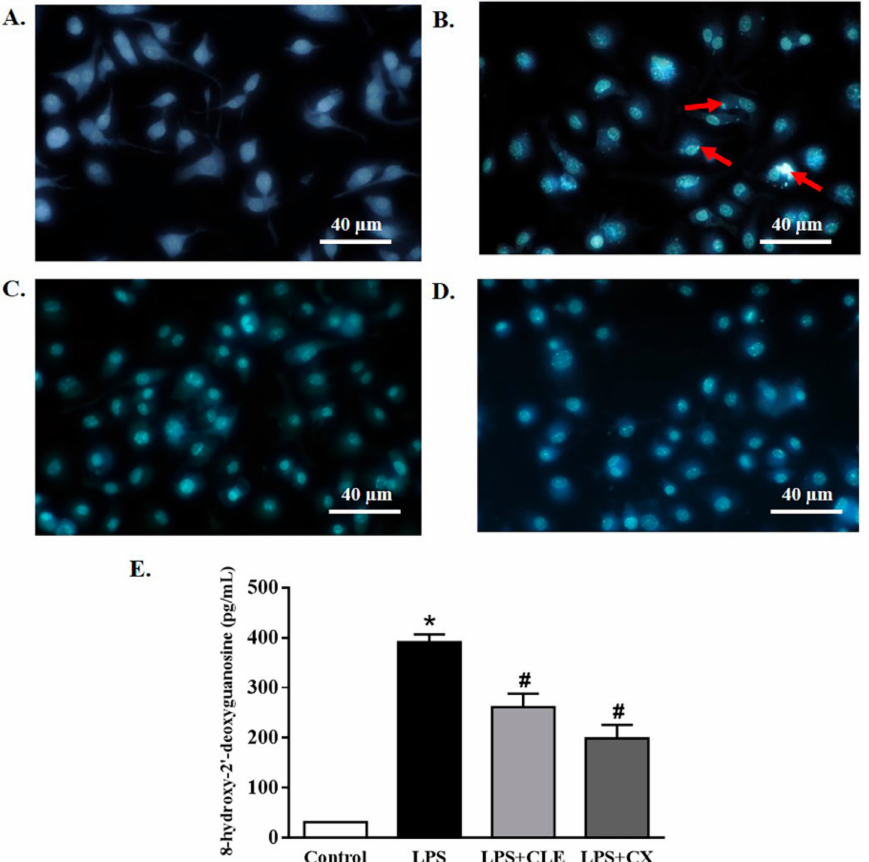
Figure 5. The effects of CLE on DNA damage in LPS-stimulated RAW 264.7 cells. Cells were plated in 12-well plates and treated with CLE or CX in the presence or absence of LPS. Cells were treated 24 h later with Hoechst 33,342 staining at 5 µ g/mL for 10 min and then observed under an inverted fluorescence microscope (original magnification, × 40). The change in the nucleus of apoptotic cells is shown by the arrows ( A – D ). The amount of 8-OHdG in the DNA was determined using an 8-OHdG-EIA kit ( E ). Values shown are mean ± SEM ( n = 5); * p < 0.05 vs. control and # p < 0.05 vs.